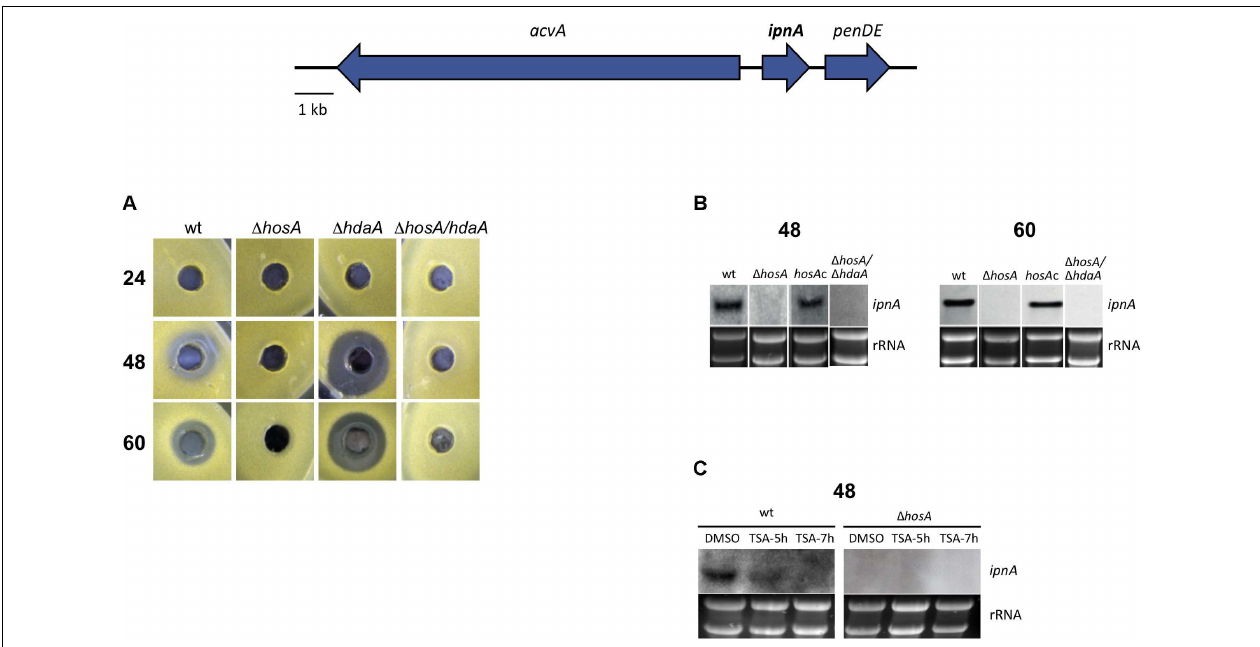
FIGURE 4 | Production of penicillin and expression of the penicillin cluster gene ipnA in different HDAC mutants. A bacterial growth inhibition assay was used for quantification of penicillin production in hosA- , hdaA- , and hosA/hdaA- delta strains compared to wildtype. Strains were grown for 24, 48, and 60 h at 37 ◦ C in a submerged culture in GMM before media (sixfold concentrated) were pipetted into wells of agar plates inoculated with the PN sensitive bacteria strain K. rhizophila (ATCC9341). After incubation over night at 37 ◦ C, the size of the bacterial growth inhibition zone was analyzed. Bacterial clearing around the well corresponds to the relative production of penicillin of the strains tested (A) . Northern blots were used to verify the results of the bioassay. hosA and hosA/hdaA mutants, a complemented hosA mutant and wt were grown for 48 and 60 h at 37 ◦ C in submerged GMM cultures. RNA of strains was hybridized with a digoxigenin-labeled probe for the penicillin cluster gene ipnA (see schematic representation of the gene cluster on top of this figure). Ethidium-stained rRNA served as quality and loading control (B) . Impact of TSA on the penicillin production was assessed. hosA mutant and the wt strain grown for 43 and 41 h in GMM were treated with 1 µ M TSA for 5 and 7 h. RNA was prepared, blotted, and hybridized with the ipnA probe. DMSO treated cultures served as negative controls (C)